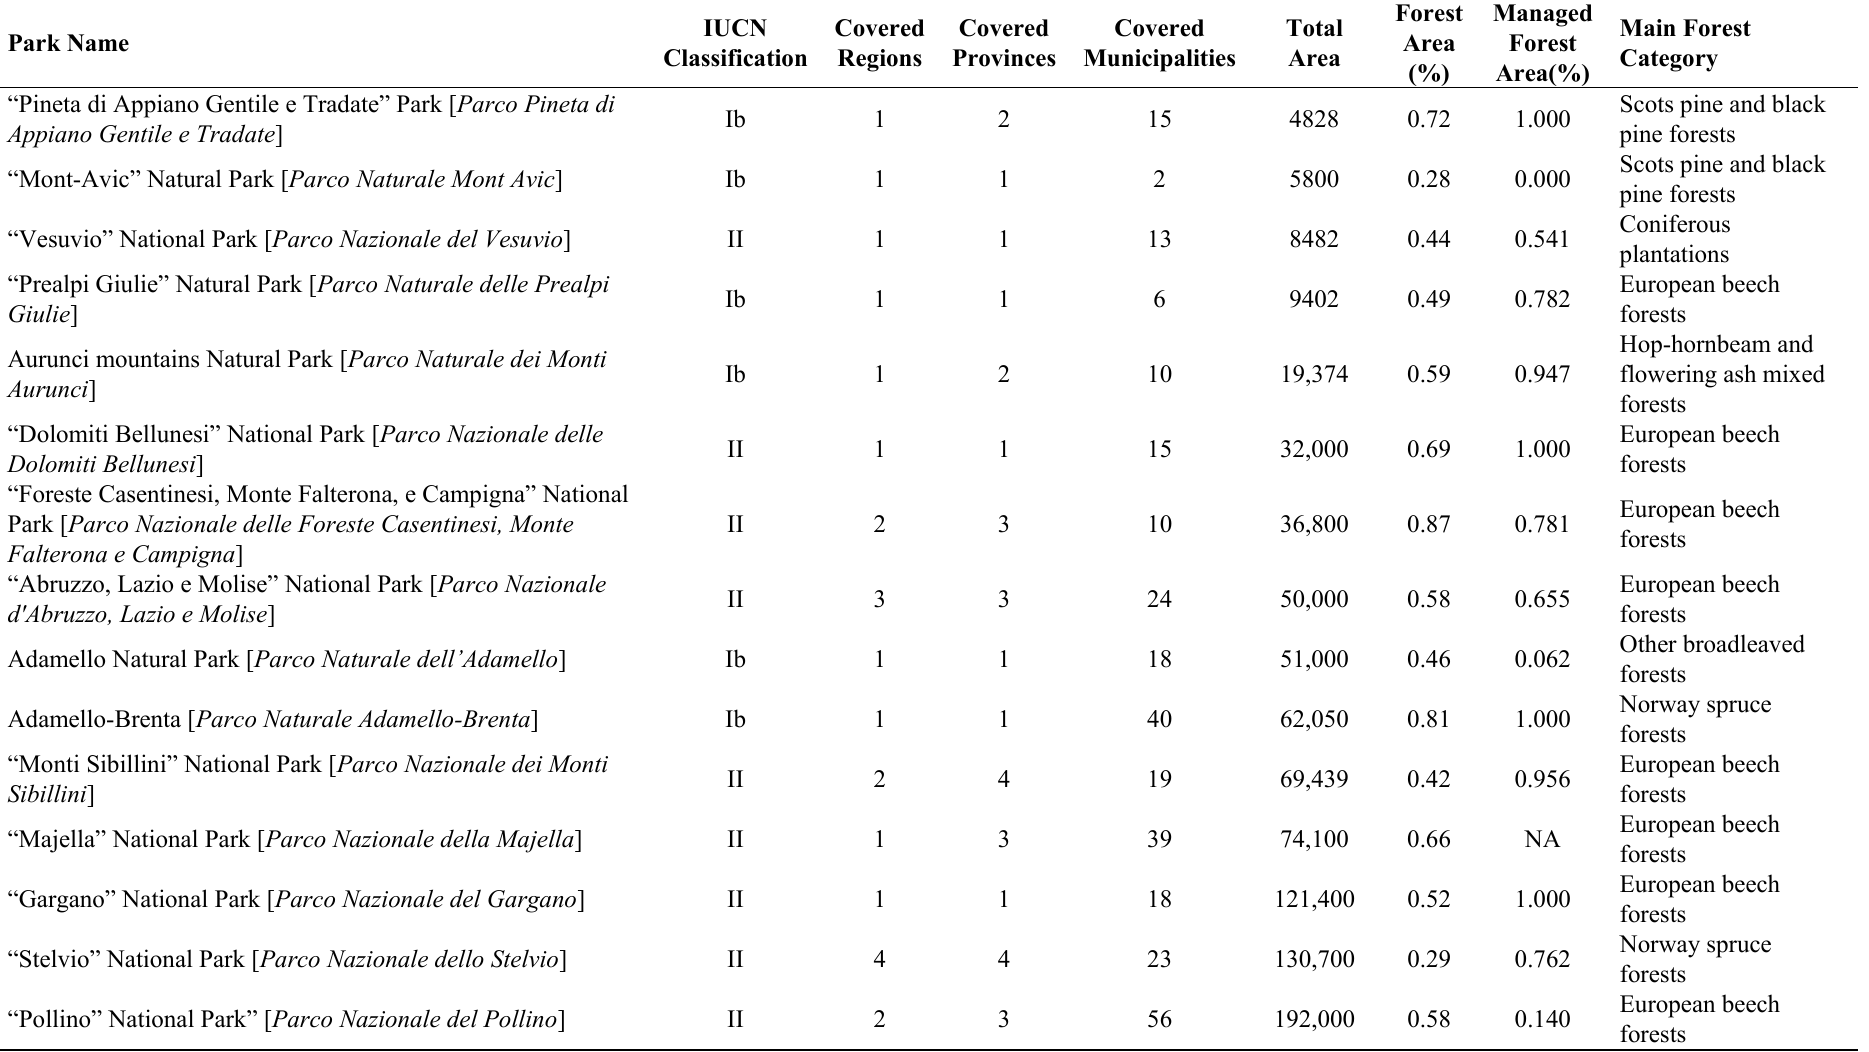
Table 4. List of surveyed National and Regional Parks. Information has been reported by the respondents in Section 1 of the questionnaire. Park